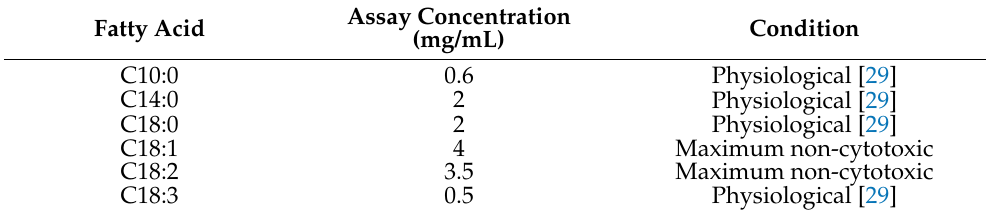
Table 2. ZIKV (10 6 PFU) was incubated either with DMEM-2% FBS, 4% PFA, or with the following non-cytotoxic concentrations of free fatty